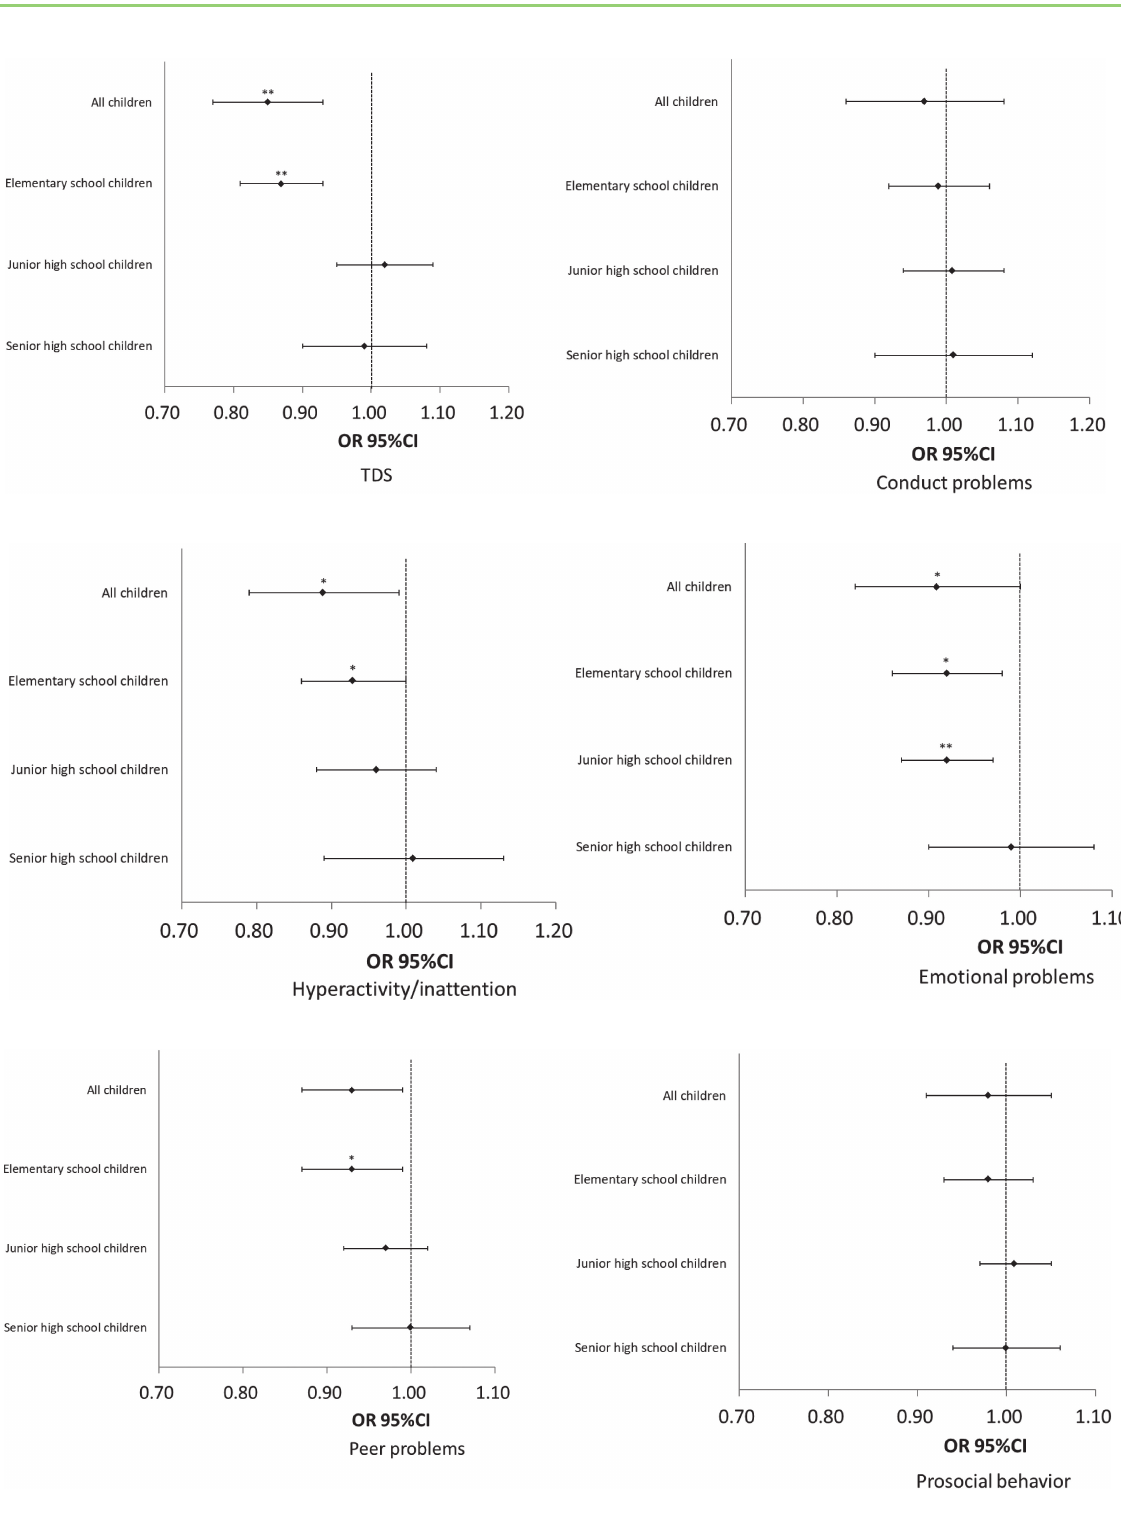
Fig. 2 Behavioral problems in children and child age at fi rst use of a mobile device OR: odds ratio. CI; con fi dence interval. TDS; total each di ffi culties score. The OR (95% CI) for children of borderline / high group, who was compared to children of normal group based on total each TDS and the fi ve subscales — conduct problems, hyperactivity, emotional symptoms, peer problems, and prosocial behavior were calculated by the logistic regression analysis, which was adjusted for child age at time of survey, sex, history of developmental concerns, health-related quality of life, sleep problems, internet addiction, school type, and interaction between exposure and school type among all children. The logistic regression analysis among children strati fi ed by school type was adjusted for the same variables excluding school type and interaction between exposure and school type. * P < 0.05, ** P <